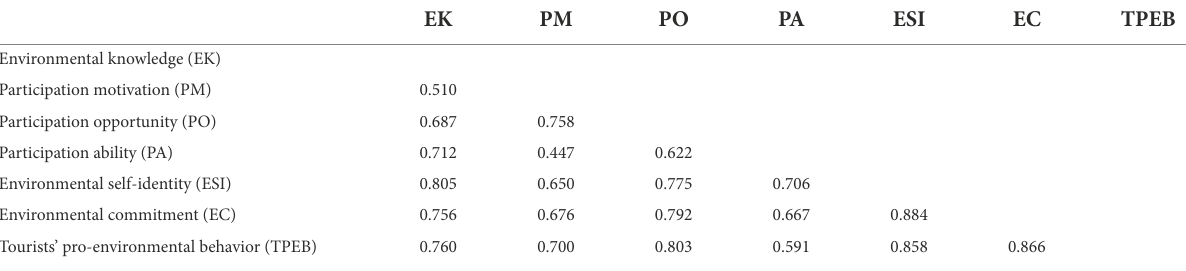
TABLE 4 HTMT discriminant validity criterion.